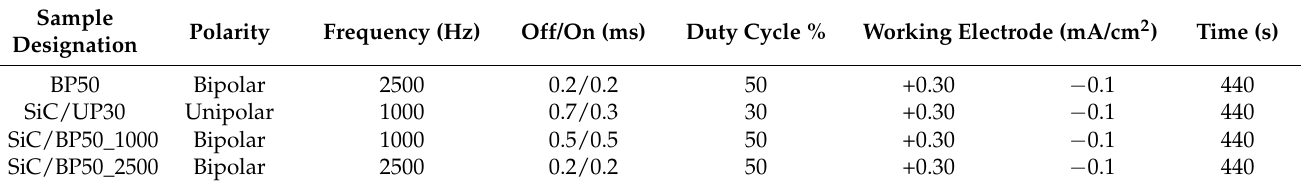
Table 1. The applied parameters, frequencies, and currents of